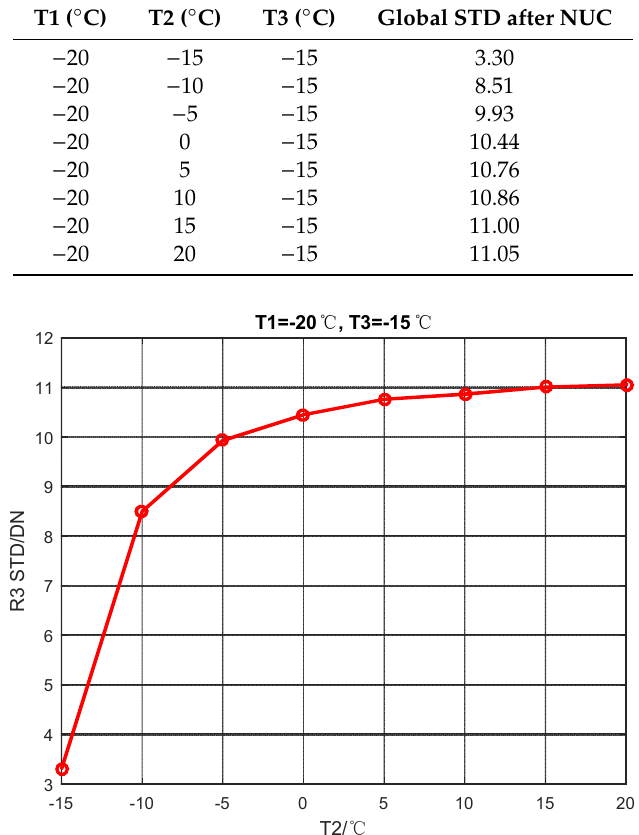
Table 3. TP NUC statistics of experiment 2.